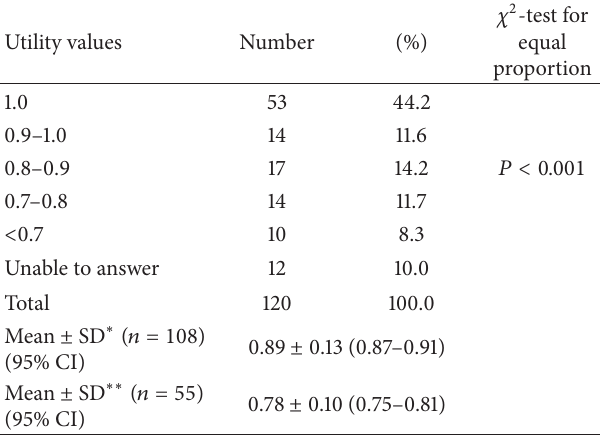
Table 2: The distribution of utility values by time trade-off method for gallstone disease ( 𝑛 = 120